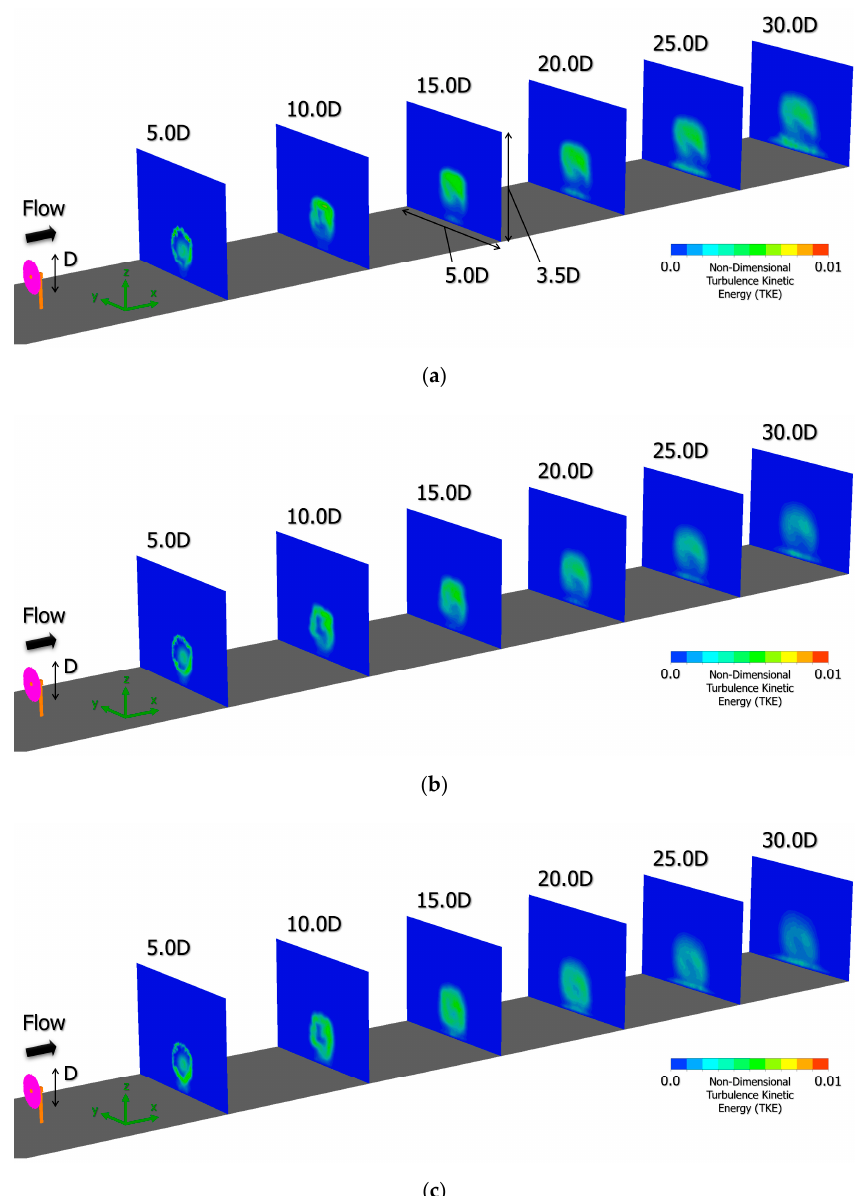
Figure A9. Spatial distribution of nondimensional turbulence kinetic energy (TKE) in the y–z plane (front view) at x = 5.0 D, 10.0 D, 15.0 D, 20.0 D, 25.0 D, and 30.0 D: ( a ) N = 4, ( b ) N = 10, and ( c ) uniform flow.